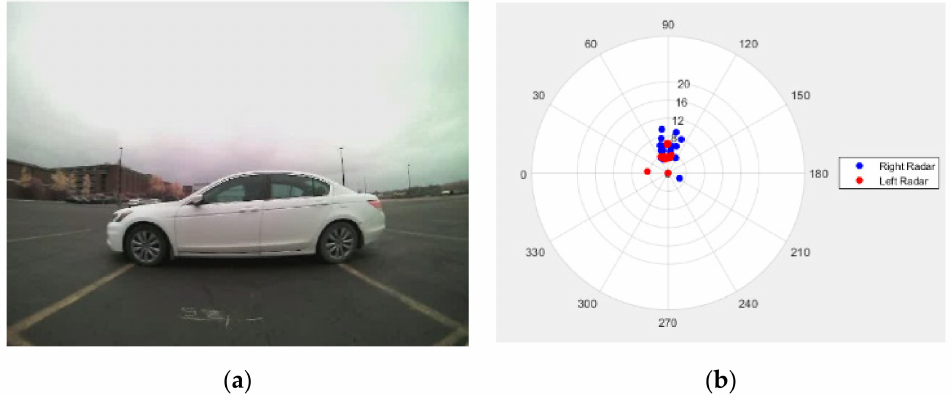
Figure 4. Validation of radar signals: ( a ) The test vehicle is placed on the pre-measured location at the center of the rear bumper; ( b ) red dots are signals from the left radar and blue dots are signals from the right